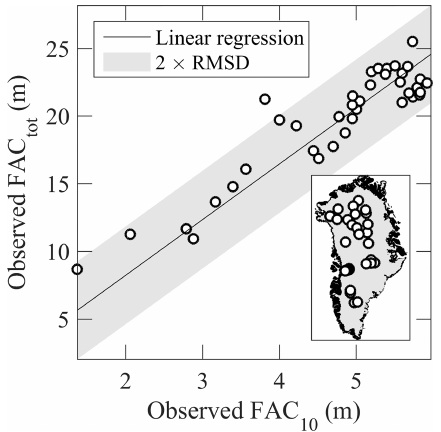
Figure 4. Linear regression used to estimate FAC tot from FAC 10